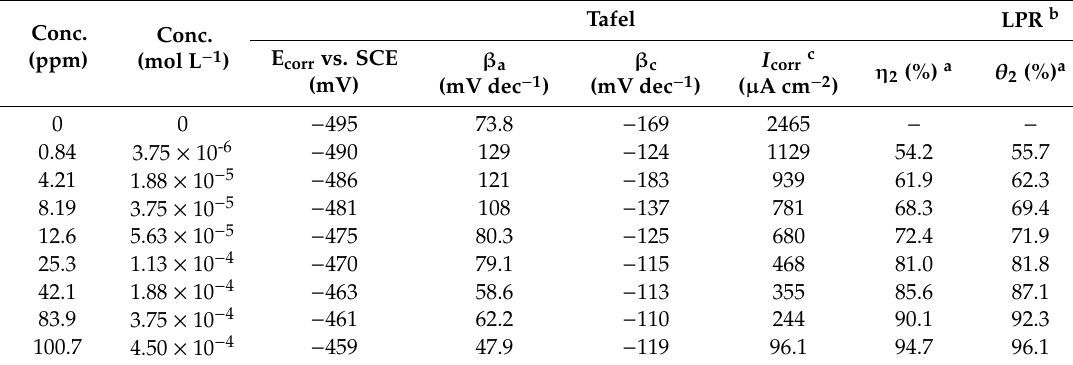
Table 5. Electrochemical results of Tafel plots and LPR of a mild steel sample in 1 M HCl containing corrosion inhibitor 7 at 333